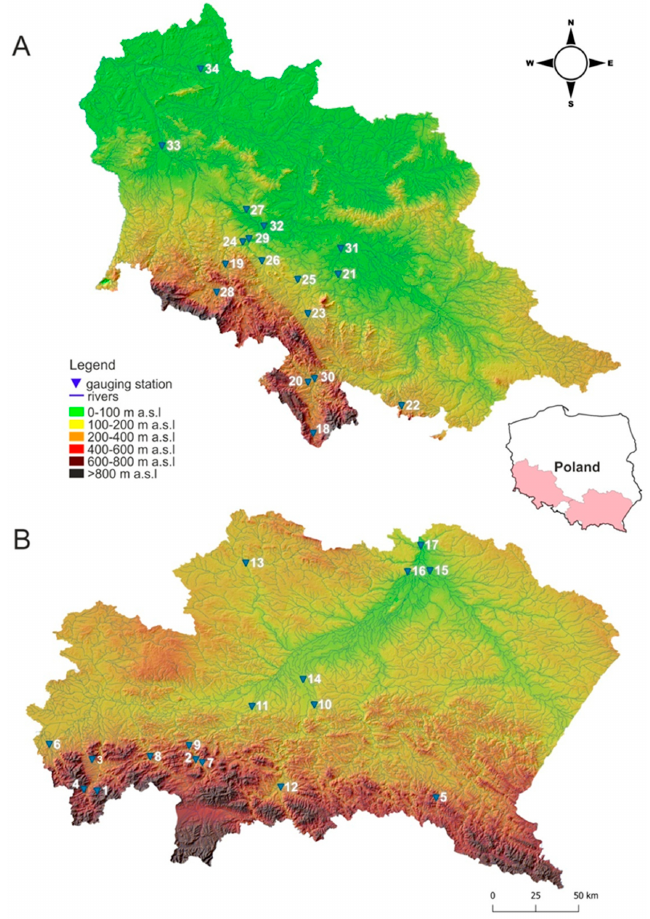
Figure 4. Location of gauging stations: ( A ) middle Oder River basin, ( B ) upper Vistula River basin (see Table 1).